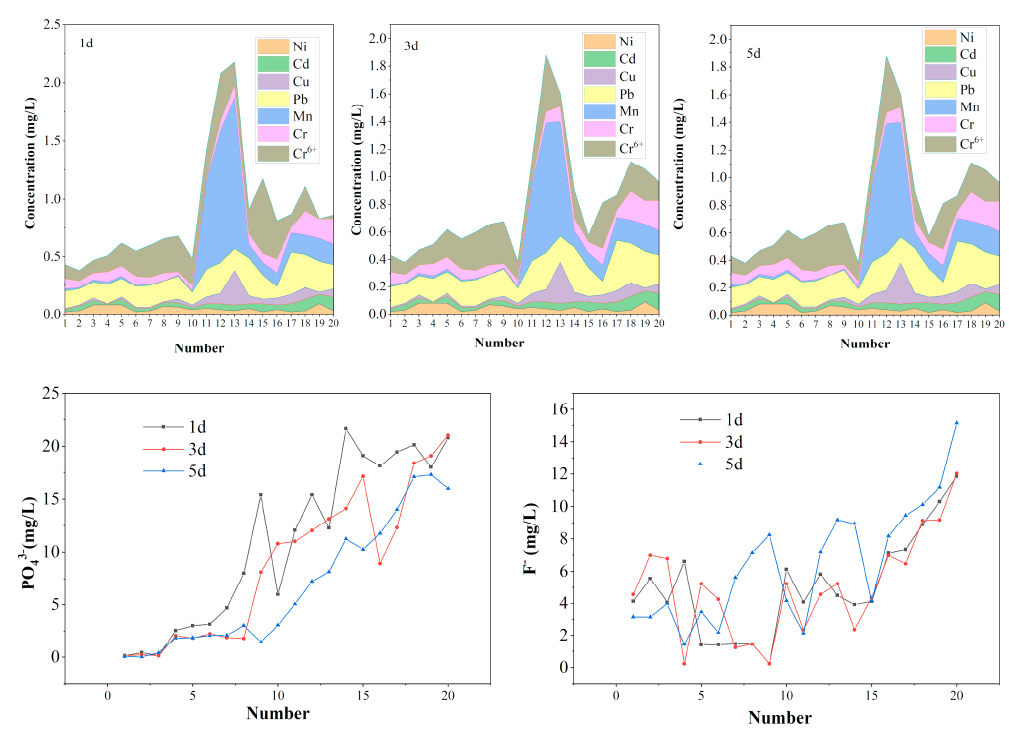
Figure 7. Leaching concentration of harmful substances.